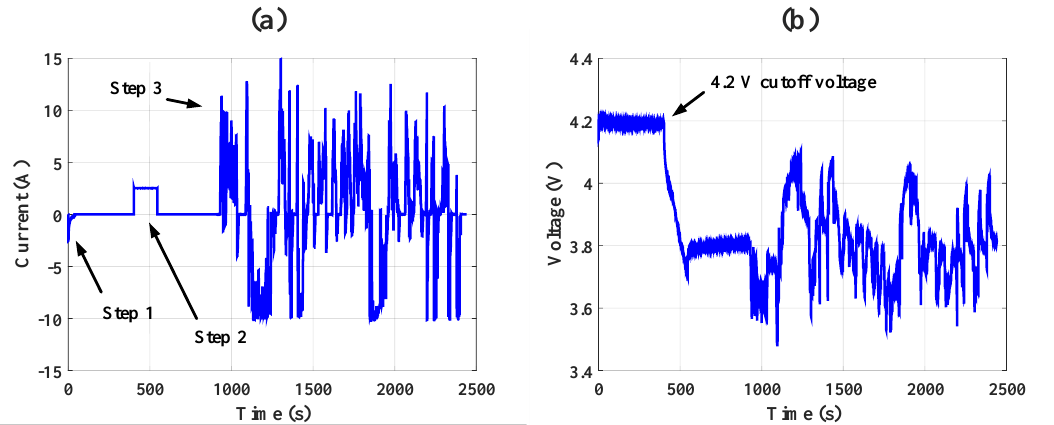
Figure 4. Experimental sequence: ( a ) engaging the current and ( b ) the resulting cell terminal